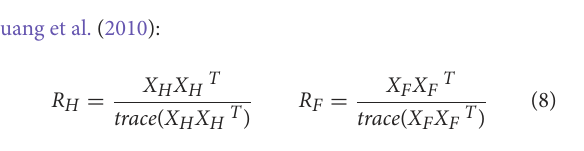
FIGURE1 Features extraction steps for the LSTM